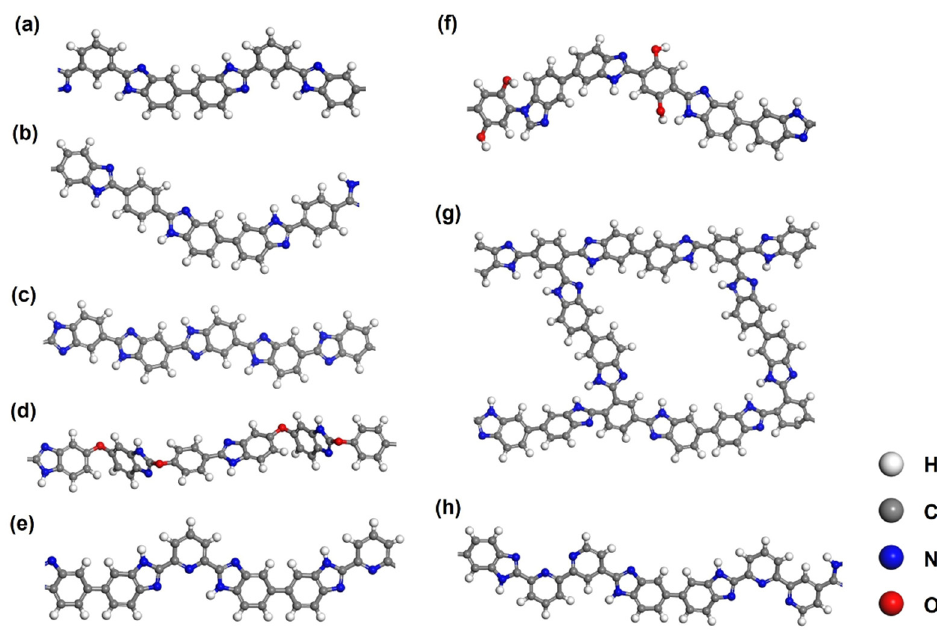
Figure 3. Graphs of polymer structures for ( a ) m-PBI, ( b ) para-PBI, ( c ) AB-PBI, ( d ) OOPBI, ( e ) Py-PBI, ( f ) 2OH-PBI, ( g ) HB-PBI, and ( h ) Bipy-PBI.